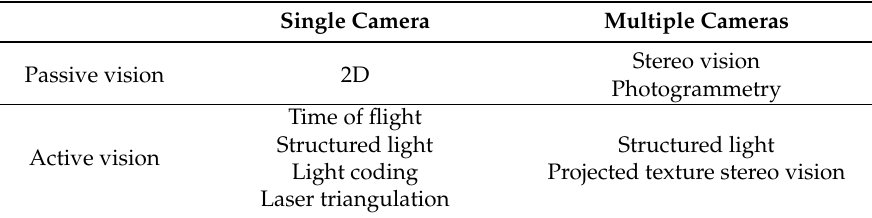
Table 1. Vision techniques classification.